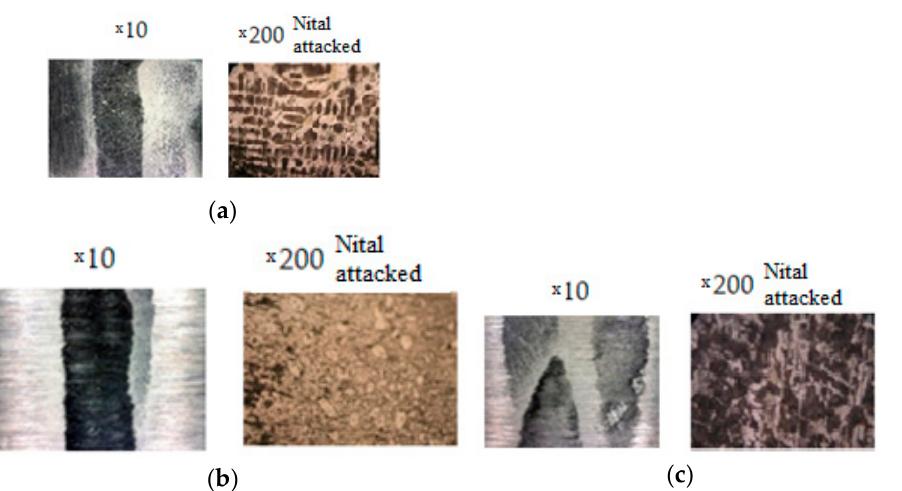
Figure 14. The surface aspect of the samples at the end of the third test program: ( a ) sample 1/1.1; ( b ) sample 2/2.1; and ( c ) sample 3/3.2.